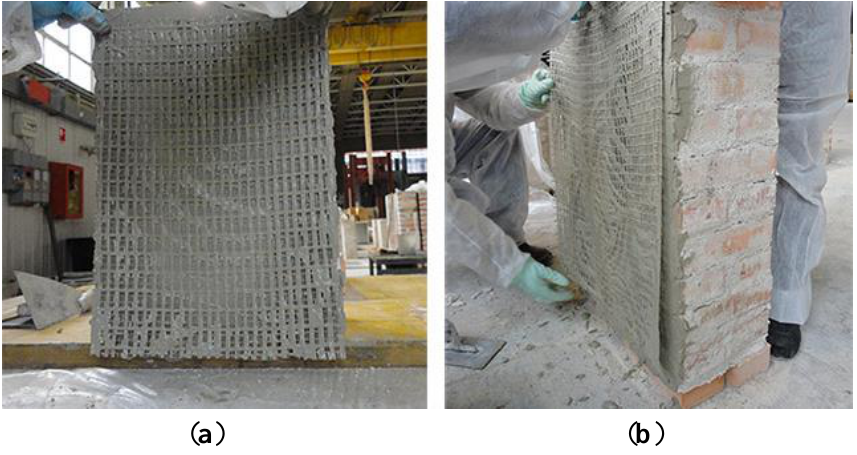
Figure 5. Application of the FRCM composites: ( a ) specimen “P”; ( b ) specimen